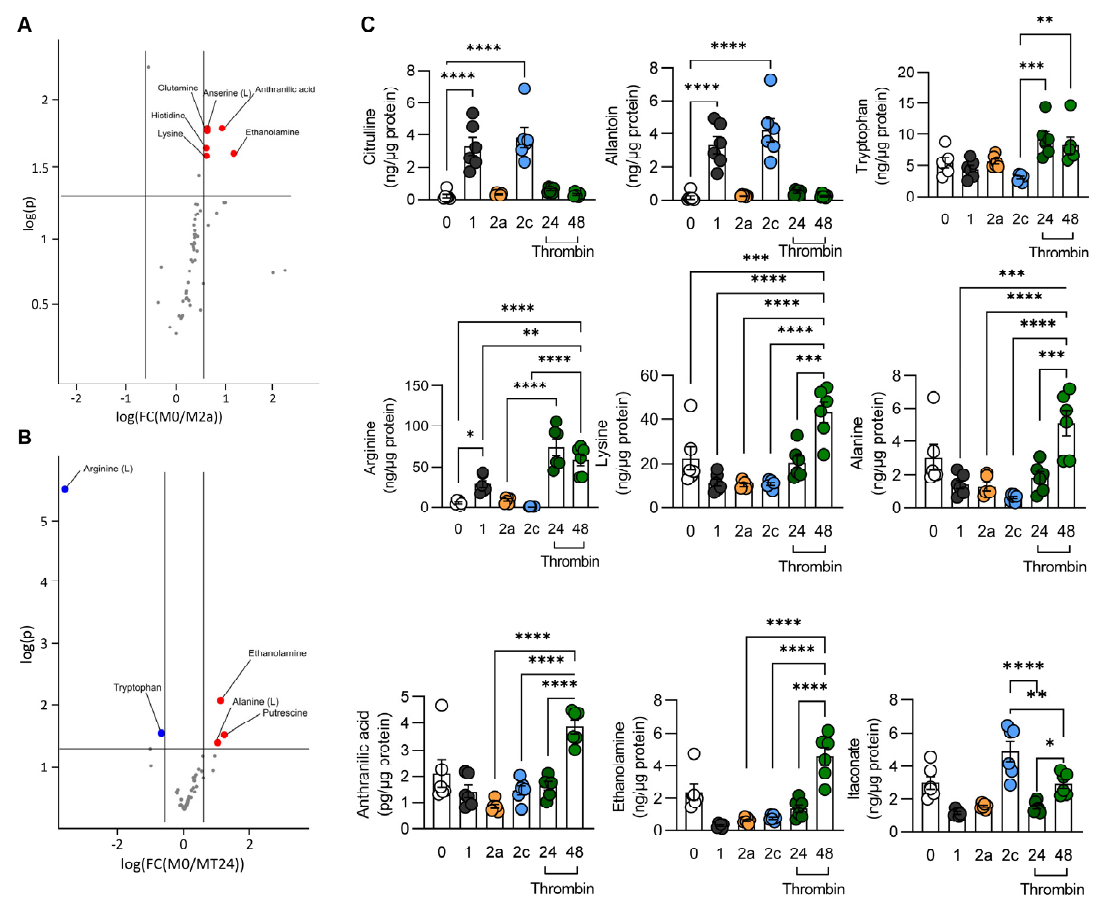
Figure 3. Effects of thrombin on macrophage amino acid metabolism. ( A ) Volcano plot comparing amino acid levels in M0 versus M2a macrophages. ( B ) Volcano plot comparing amino acid levels in M0 macrophages compared to macrophages treated with thrombin for 24 h (MT24). ( C ) Levels of selected amino acids in M0-, M1-, M2a-, and M2c-polarized macrophages versus macrophages treated with thrombin for up to 48 h; n = 6 mice (one-way ANOVA and Tukey’s multiple comparison test). * p < 0.05, ** p < 0.01, *** p < 0.001, **** p <